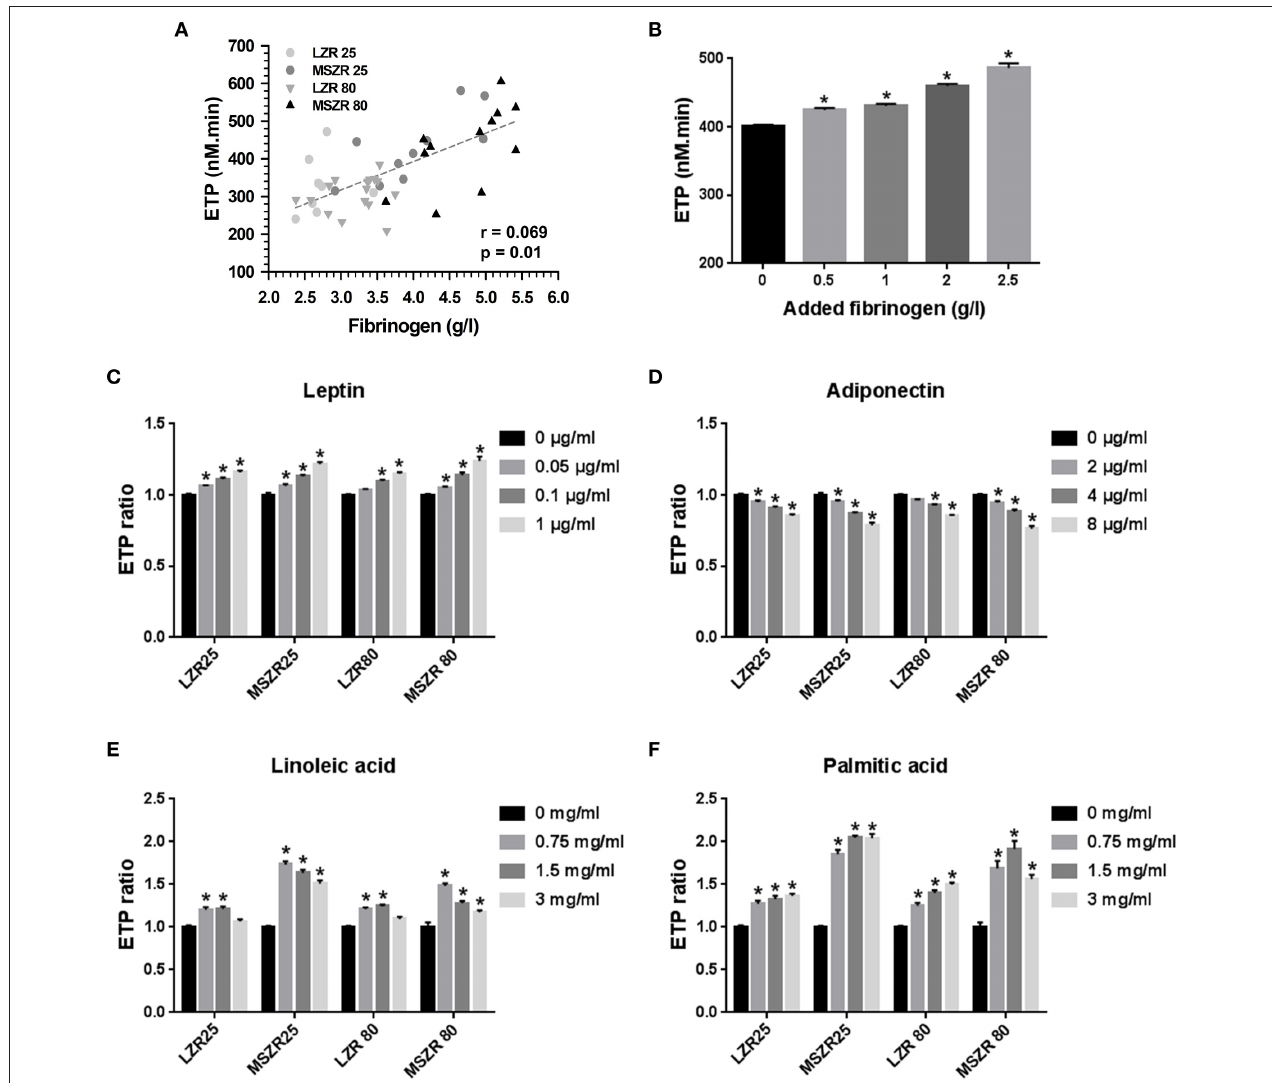
FIGURE 2 | Effect of fibrinogen, adipokines, and free fatty acids on thrombin generation. (A) Correlation between ETP and plasma fibrinogen concentration of 25 and 80 week-old LZR and MSZR ( r = 0.069, p = 0.01). (B) ETP values in 25 week-old LZR platelet free plasma supplemented with 0.5, 1.0, 2.0, or 2.5 g/l fibrinogen. (C–F) ETP values, expressed as ratios of values in presence of adipokines or free fatty acids to those obtained with no addition for each group, in platelet free plasma supplemented with 0.05, 0.1, or 1.0ng/ml leptin (C) , with 2, 4, or 8 µ g/ml adiponectin (D) , with 0.75, 1.5, or 3 mg/ml of linoleic acid (E) or with 0.75 1.5, or 3 mg/ml of palmitic acid (F) . Results are mean ± standard error of the mean ( n = 11–16). * p < 0.05 vs. no addition.